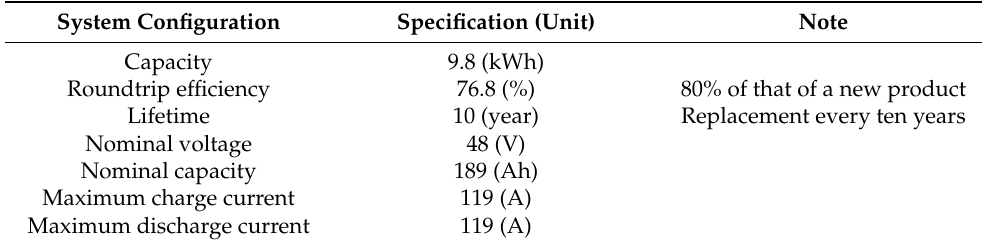
Table 6. Specifications of the RBESS (after efficiency